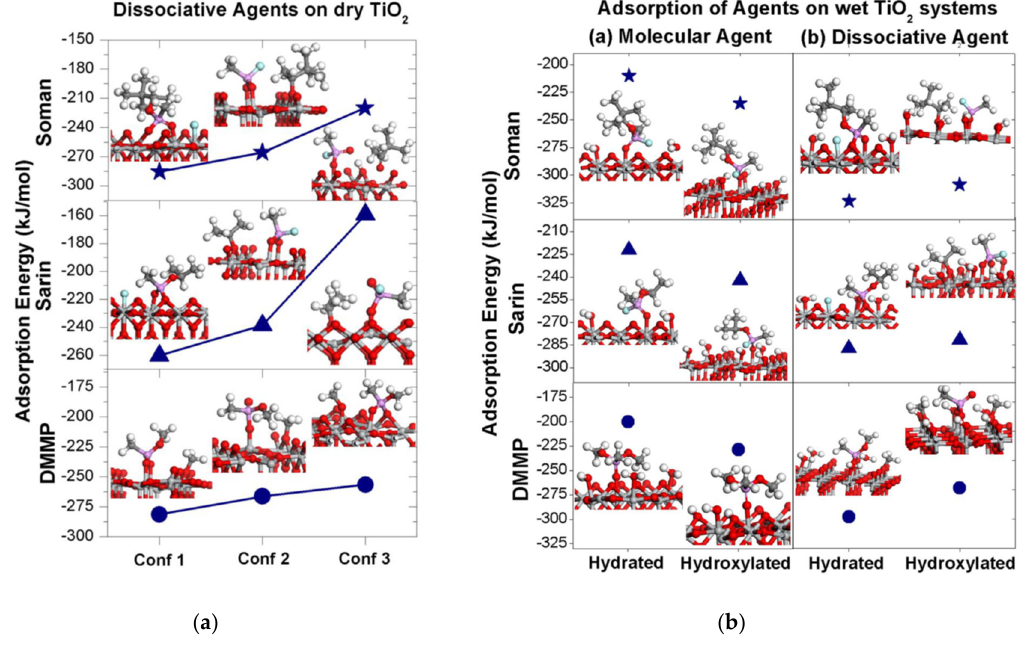
Figure 6. Molecular and dissociative adsorption of dimethyl methylphosphonate (DMMP), sarin, and soman over ( a ) clean rutile TiO 2 (110) surface and ( b ) hydroxylated and hydrated rutile (110) surface. Reproduced from Reference [55] with permission; copyright (2018) Elsevier.